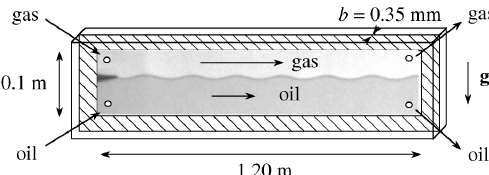
Figure 6. Reproduced from [16]. Sketch of the experimental setup to study the subcritical Kelvin–Helmholtz instability in a Hele–Shaw cell. Nitrogen gas and silicon oil were injected from the left into a thin cell between two parallel glass plates. Gravity is shown by an arrow marked g . An initial sine perturbation of the interface was imposed at the end of a splitter tongue where fluids met (left), and this was observed downstream (right).